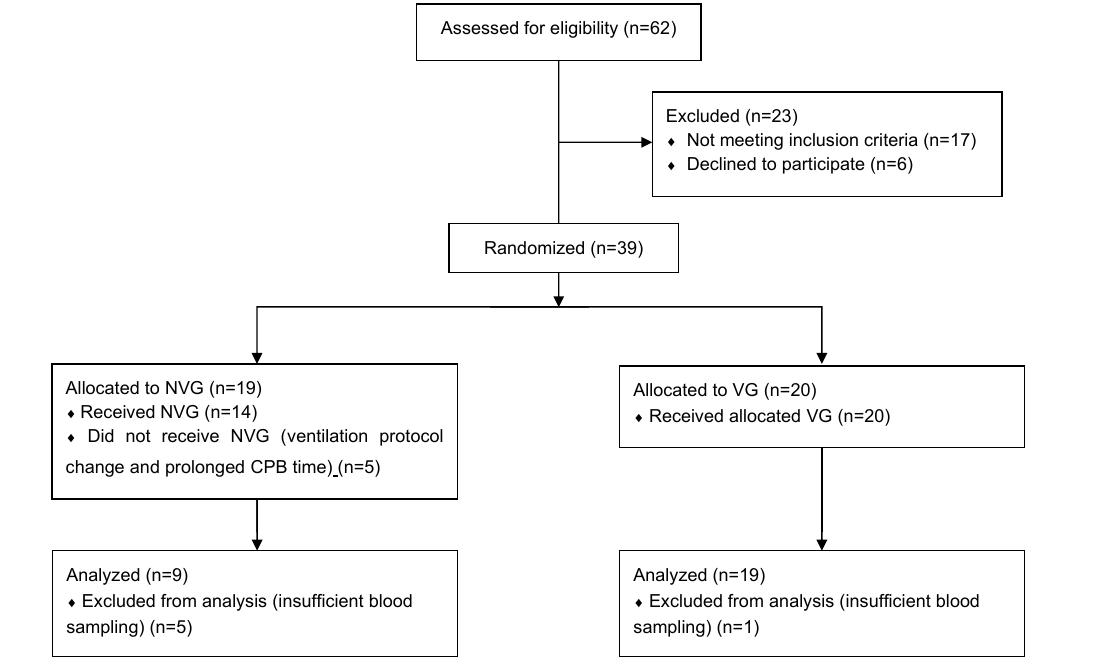
Fig. 1 - CONSORT flow diagram. CPB=cardiopulmonary bypass; NVG=non-ventilation group; VG=ventilation